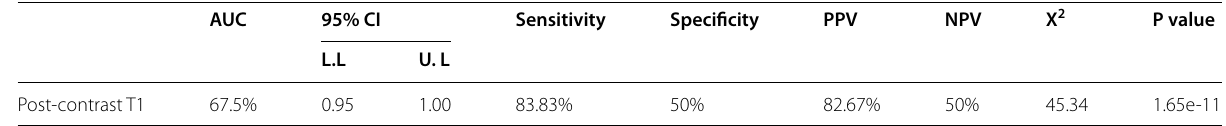
Table 4 Agreement (sensitivity, specificity) for post-contrast T1